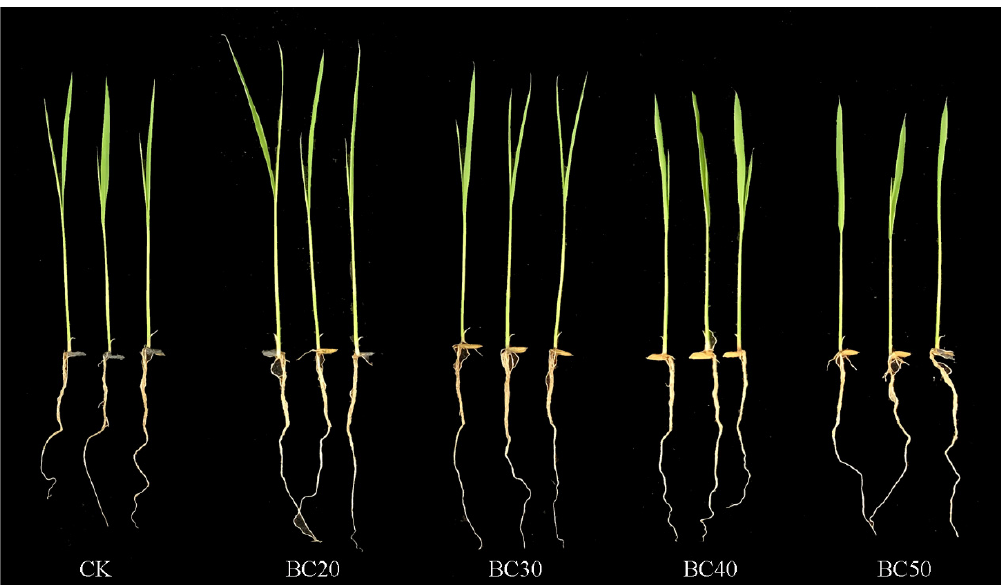
Figure 2. Pictorial illustration of different content of BC coating treated rice seedlings at 8 DAS under growth chamber experiment. CK: untreated seeds, numbers after BC denote different BC content used for seed coating.